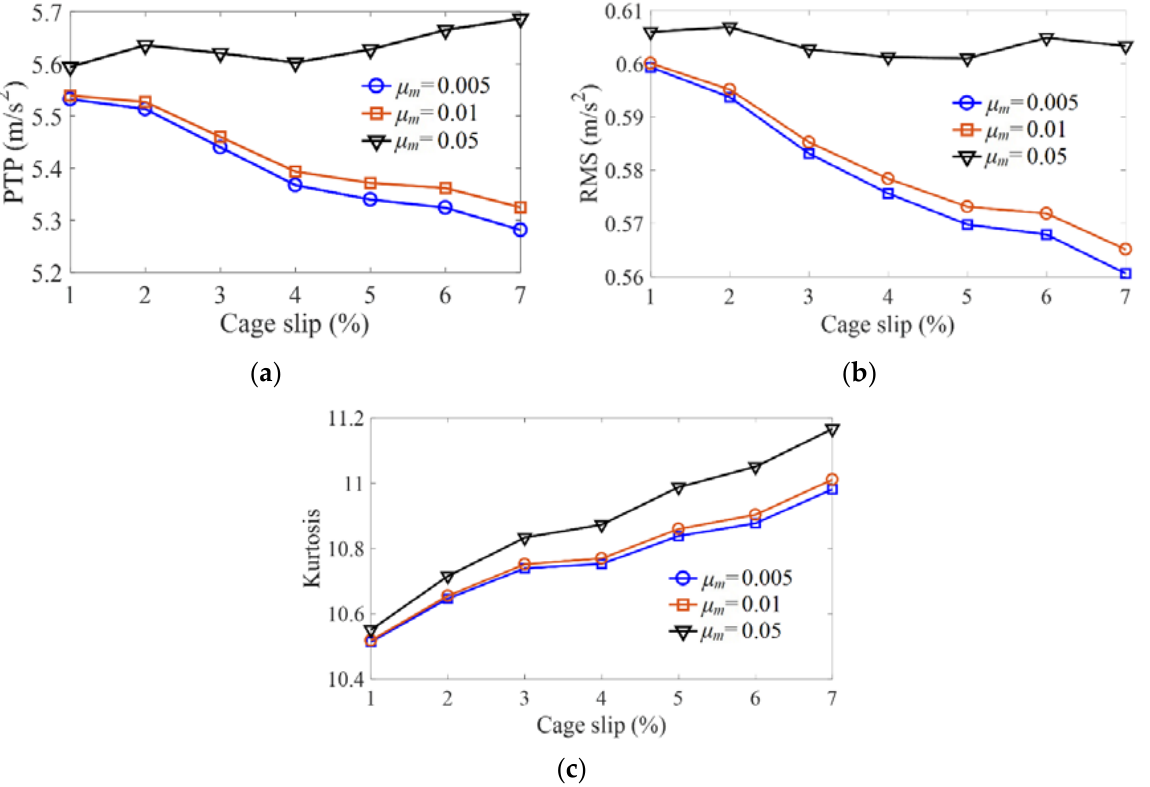
Figure 12. Effect of cage sip on statistical indicators of the acceleration of the inner raceway under different friction coefficients ( W = 2000 N, ω s = 2000 rpm): ( a ) PTP value; ( b ) RMS value; ( c ) kurtosis value.